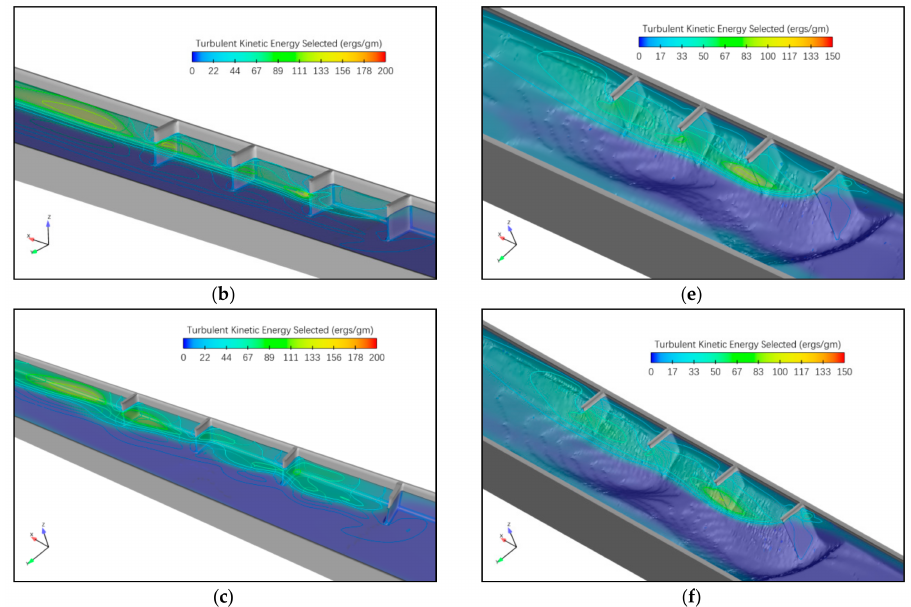
Figure 8. The turbulent energy contours of di ff erent spur dike spacing. ( a ) fixed bed for 2 l spacing; ( b ) fixed bed for 3 l spacing; ( c ) fixed bed for 4 l spacing; ( d ) movable bed for 2 l spacing; ( e ) movable bed for 3 l spacing; ( f ) movable bed for 4 l spacing.